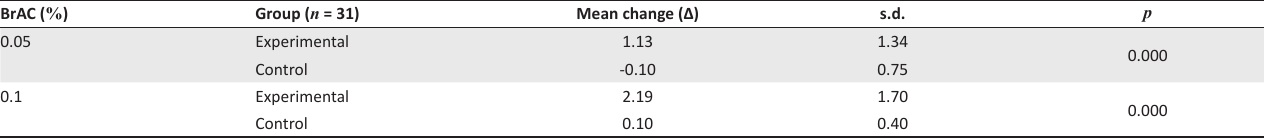
TABLE 1: Mean change in horizontal heterophoria at distance for blood respiratory alcohol concentration of 0.05 % and 0.10 % . BrAC ( % ) Group ( n = 31) Mean change (∆) s.d. 0.05